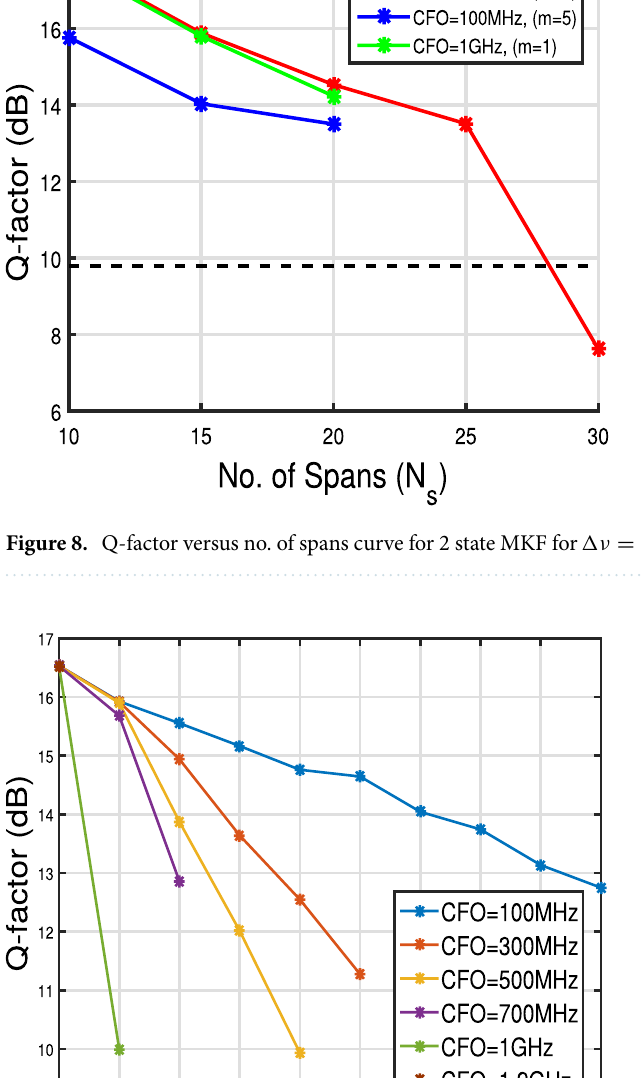
Figure 9. Q-factor versus step size of 2 state MKF for �ν 0 dBm. For reference, Q-factor corresponding to 10 −